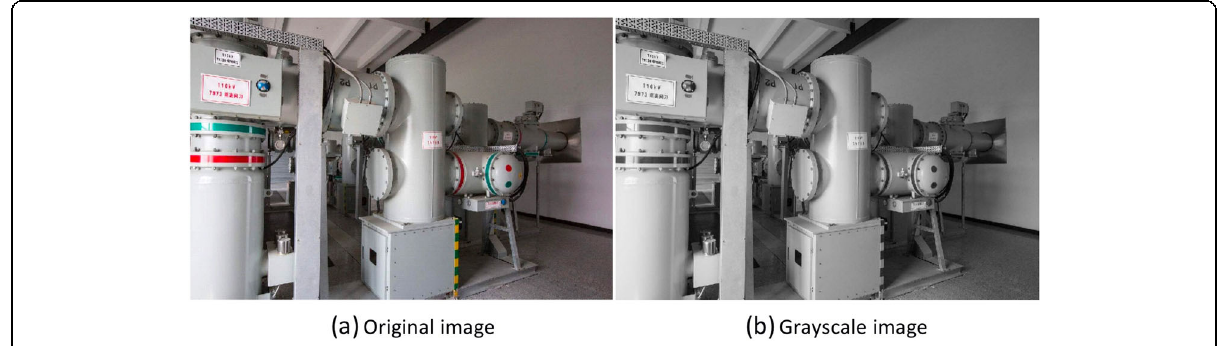
Fig. 1 Grayscale processing. a Original image. b Grayscale image